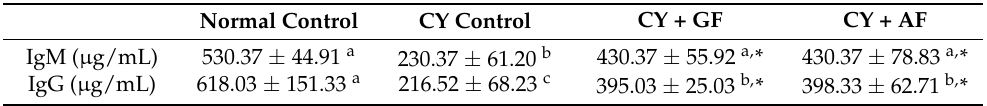
Table 3. Effect of GF and AF on the plasma IgG, IgM level in BALB/c mice immunosuppressed by